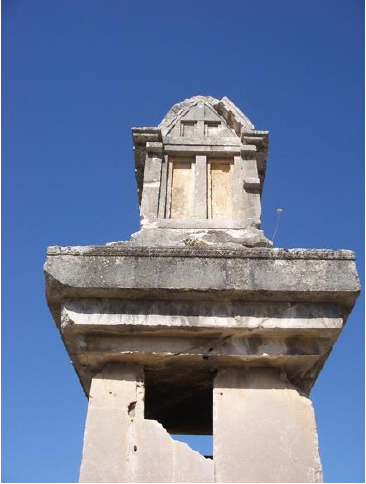
Figure 2. Pillar tomb. (“Lycian Tomb” by indie_shots is licensed under CC BY-NC-ND 2.0). The pillar tomb is shaped as a monolith with a tapered triangular top which stands on top of a rectangular stone base. The top pillar is generally a single chamber, measuring only a few meters within the chamber, large enough to contain a full sized man. The base may either have been directly on the ground or further elevated on a stepped